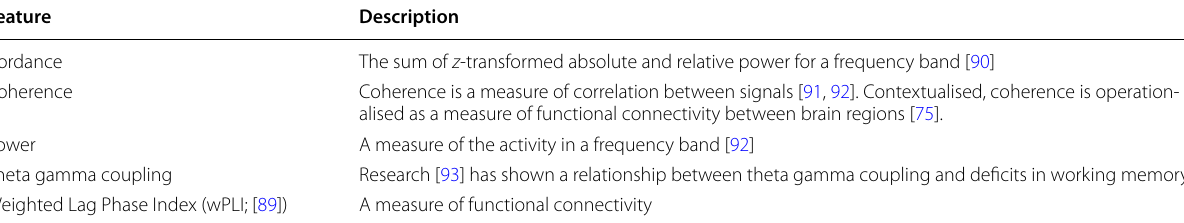
Table 4 EEG feature